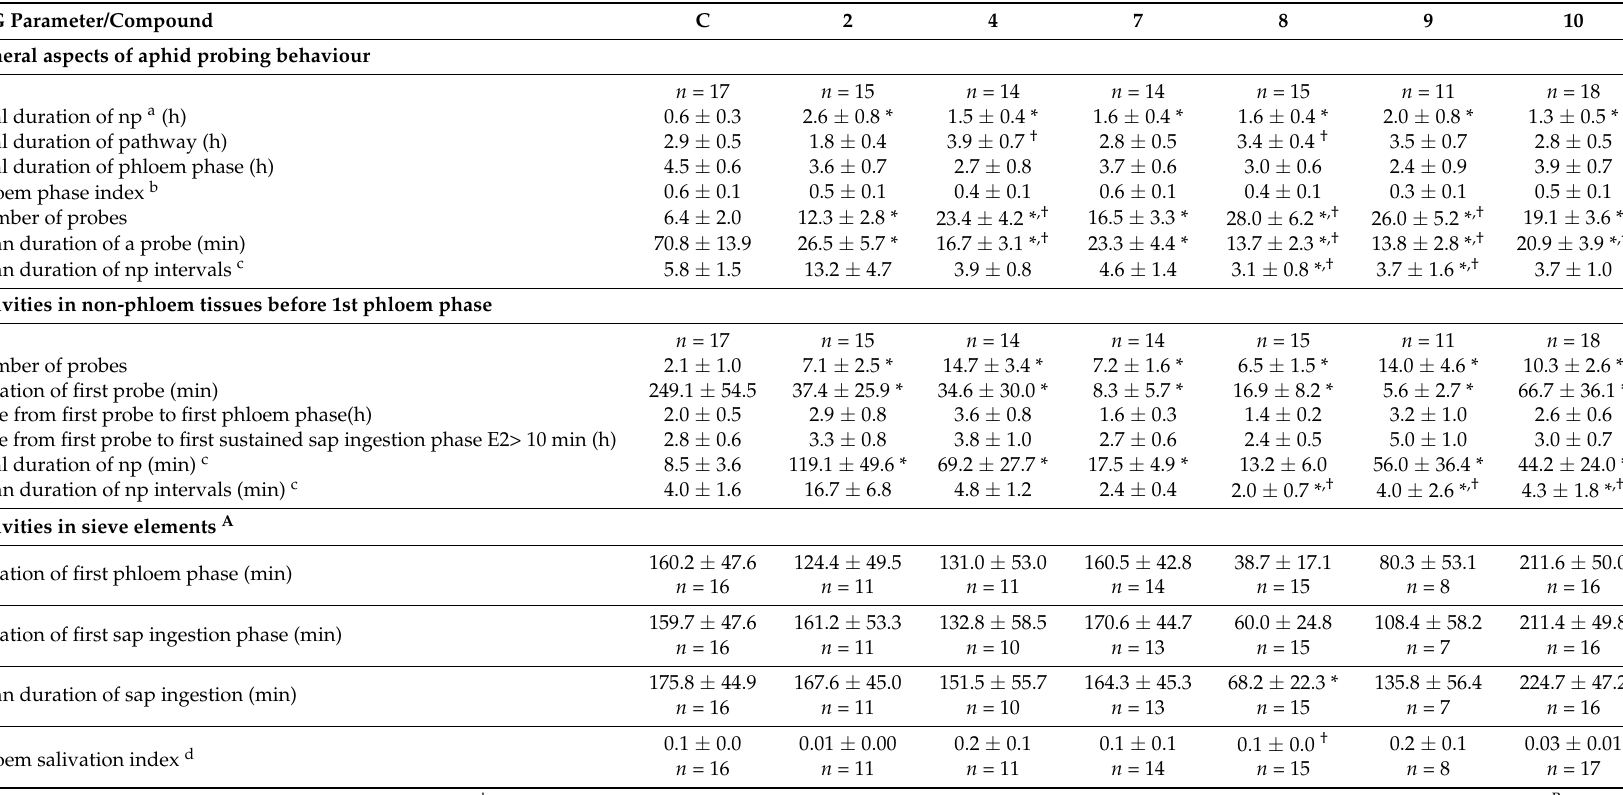
Probing behaviour (EPG parameters) of Myzus persicae on Brassica rapa subsp. pekinensis leaves treated with dihydrojasmone ( 2 ) and its derivatives: (+)-( R )-4-hydroxydihydrojasmone ( 4 ), 3,4-dihydro-5-methyl-6-pentyl-2 H -pyran-2-one ( 7 ), 5-methyl-6-pentyl-1,13-dioxabicyclo[4.1.0]hepan-2-one ( 8 ), (-)-5-hydroxy-5-methyl-6-pentyltetrahydro-2 H -pyran-2-one ( 9 ), and 5-methyl-6-pentyl-1,13-dioxabicyclo[4.1.0]hepan-2-ol ( 10 ) A . The same plant species was used to maintain the aphid stock